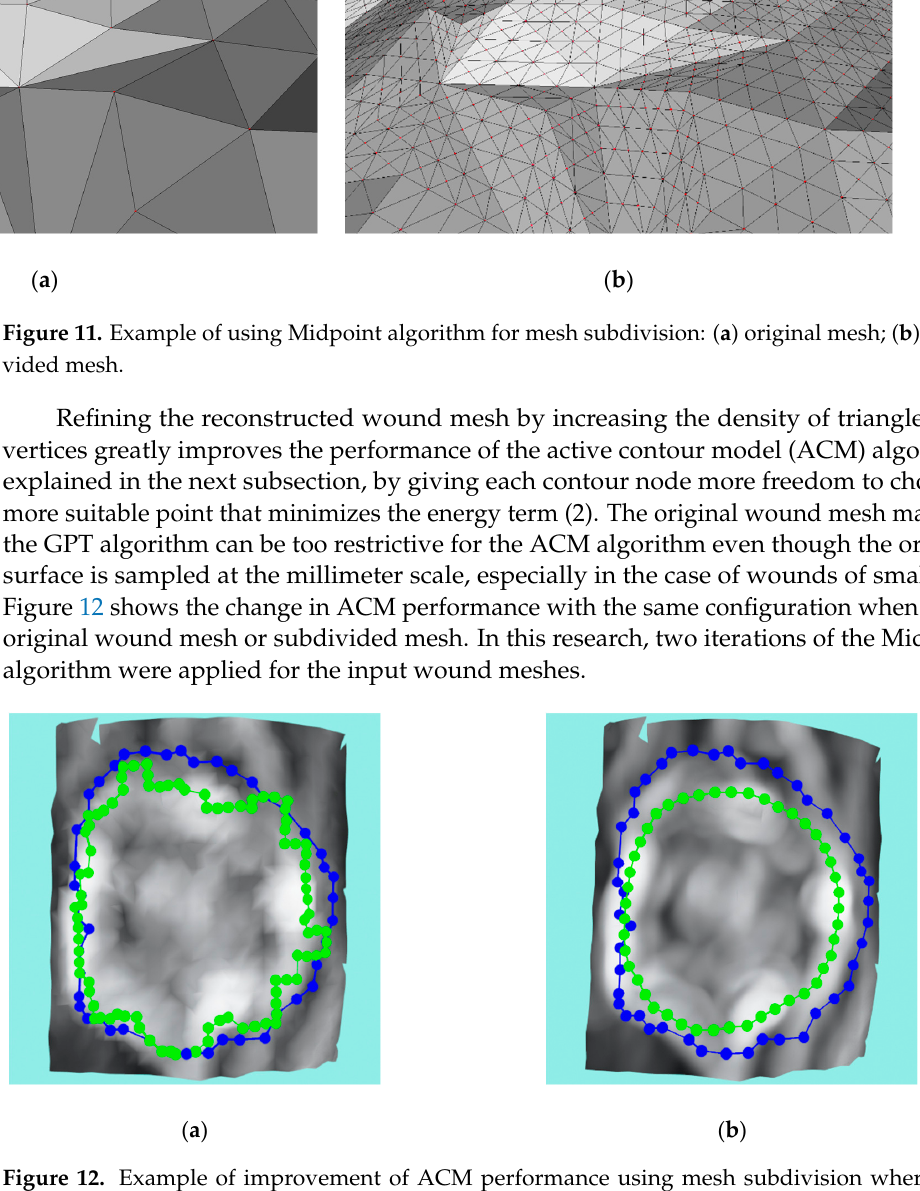
Figure 12. Example of improvement of ACM performance using mesh subdivision where blue represents initial contour while green is the final contour: ( a ) no subdivision used; ( b ) Midpoint subdivision used.